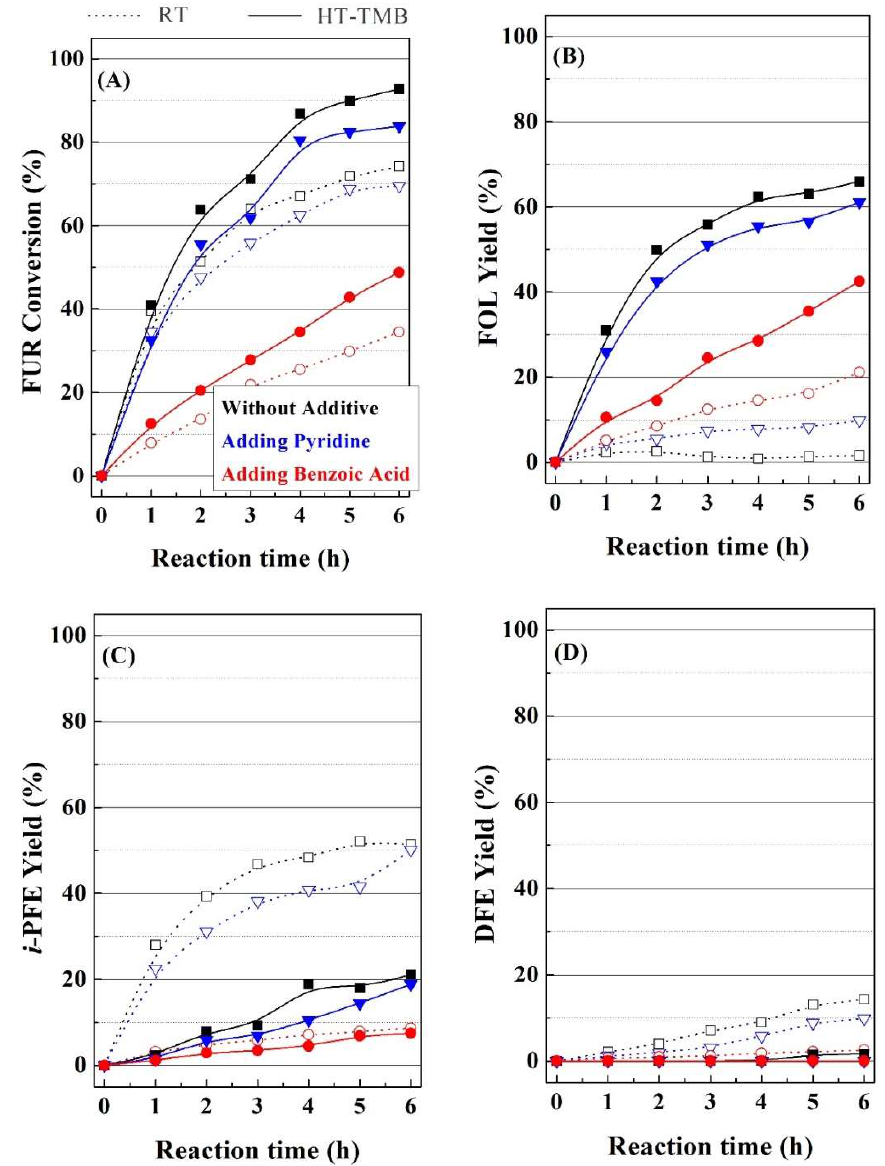
Figure 11. ( A – D ) Inhibitory role of the pyridine and benzoic acid in the MPV reaction of FUR using RT and HT-TMB catalysts. (Experimental conditions: 0.1 g of catalyst, reaction temperature: 110 °C, i -POH/FUR molar ratio: 50, FUR/Catalyst mass ratio: 1, FUR/Benzoic acid or FUR/Pyridine molar ratio of 1).